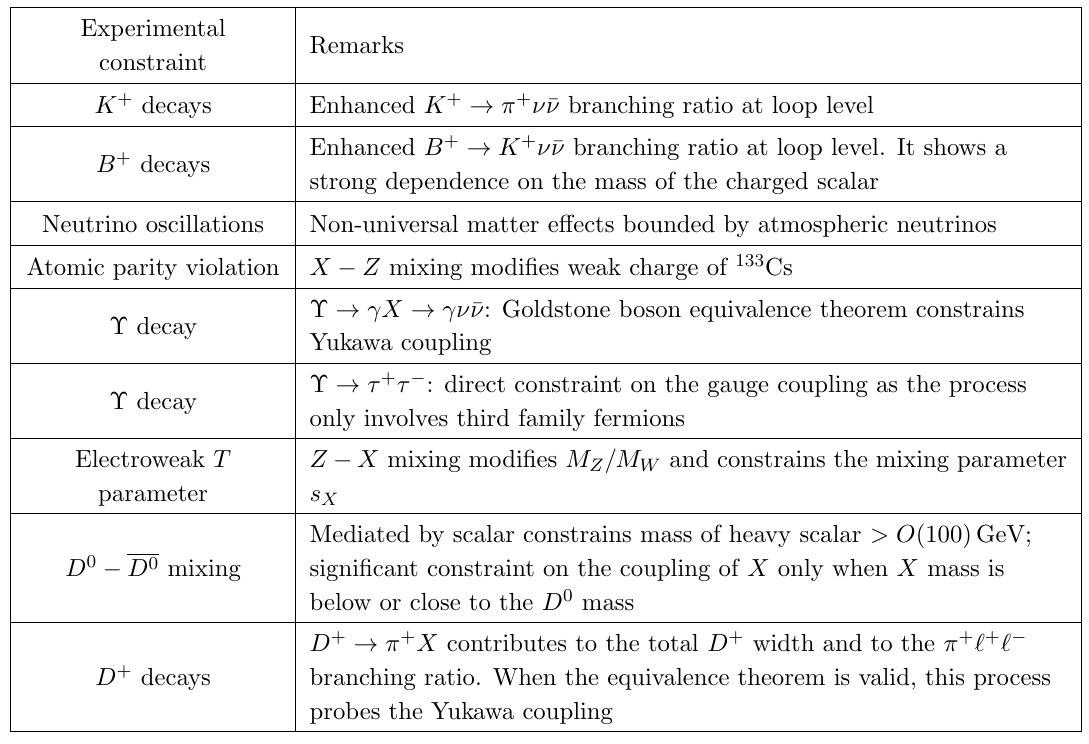
Table 2. A summary of the major experimental constraints on the